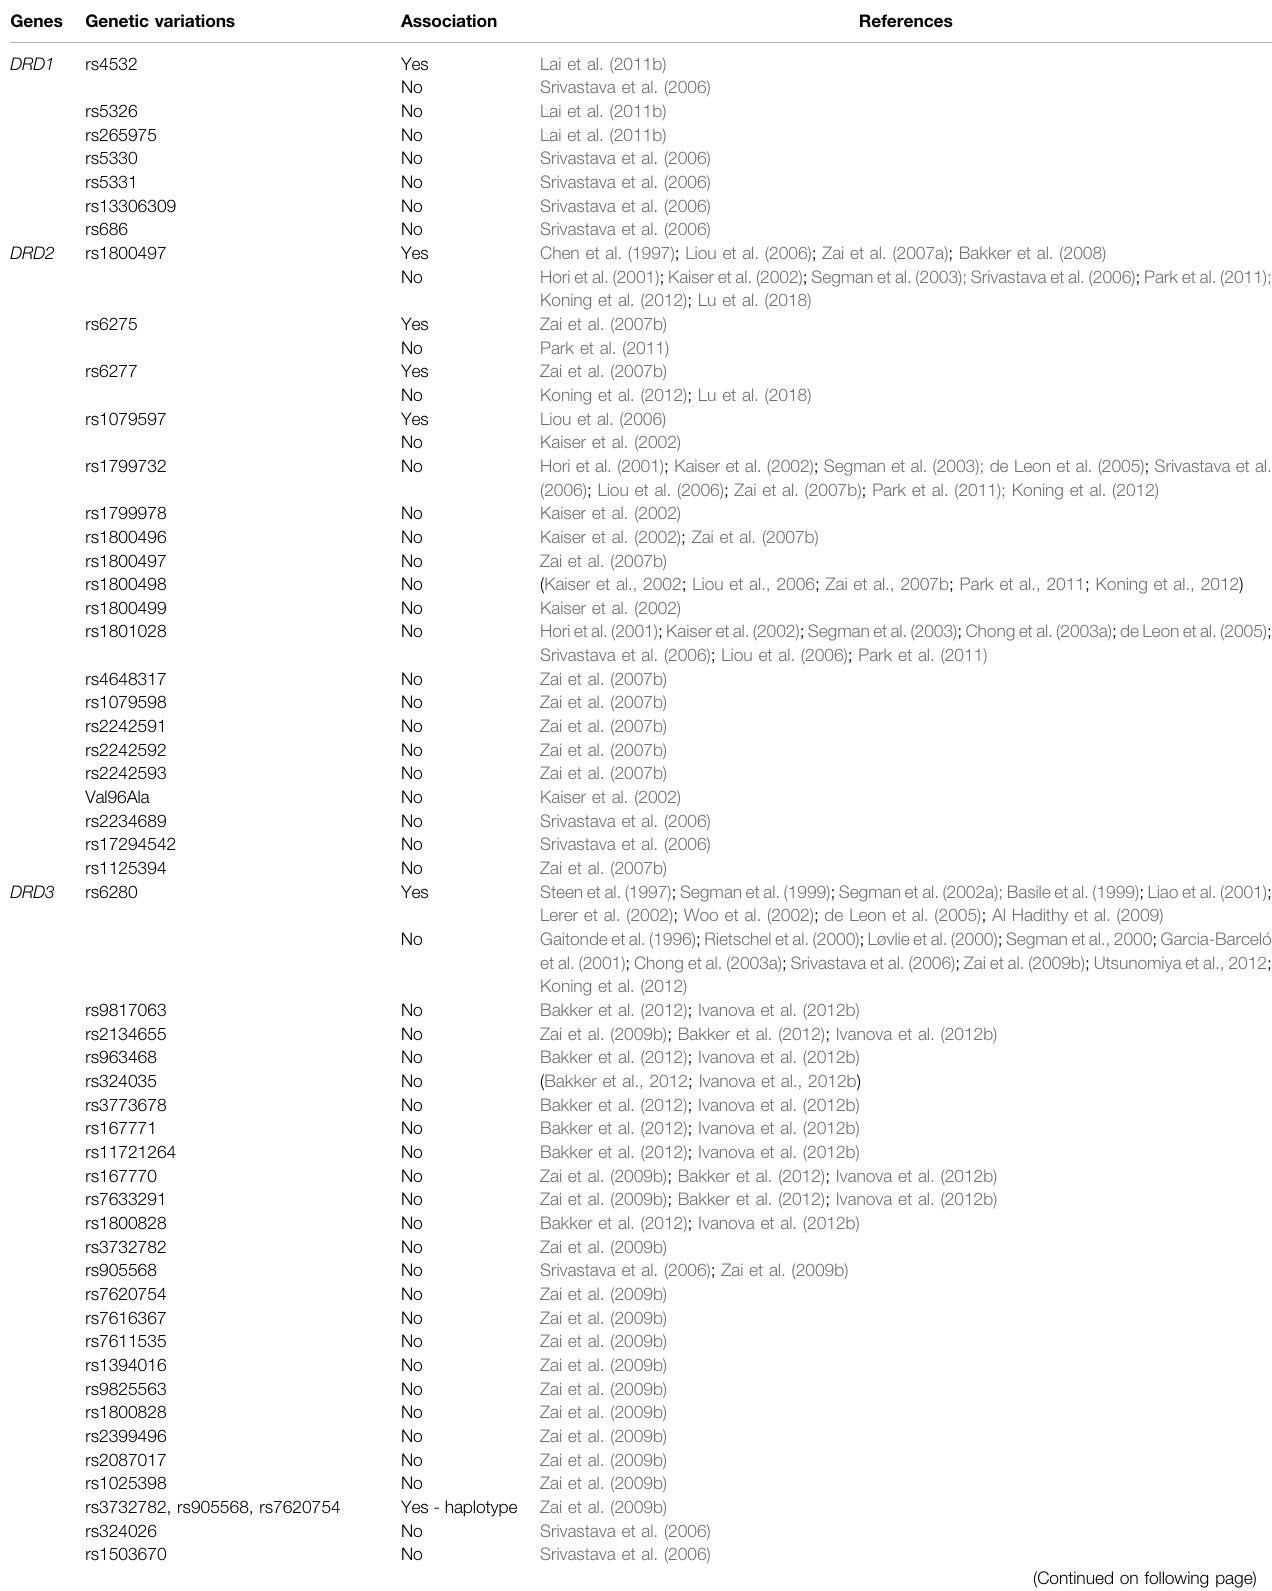
TABLE 2 | Genetic variability of dopamine receptors and its association with TD. Genes Genetic